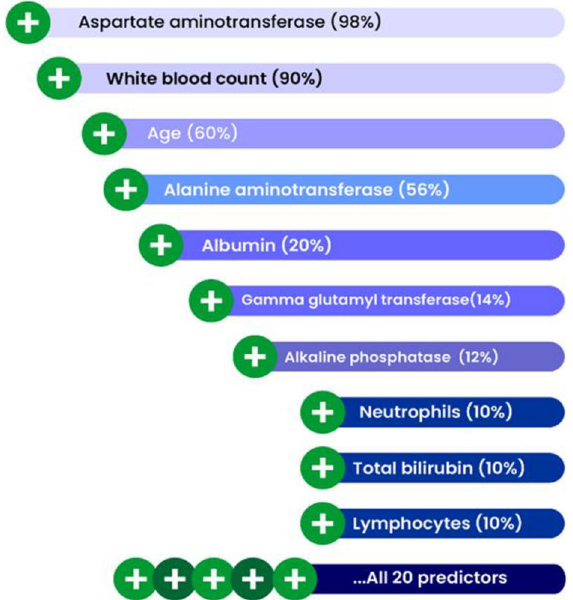
Figure 2. Variable importance from random forest analysis showing the leading predictors of HBsAg immunoassay results. The percentage in brackets represents the contribution of each predictor to the model performance.